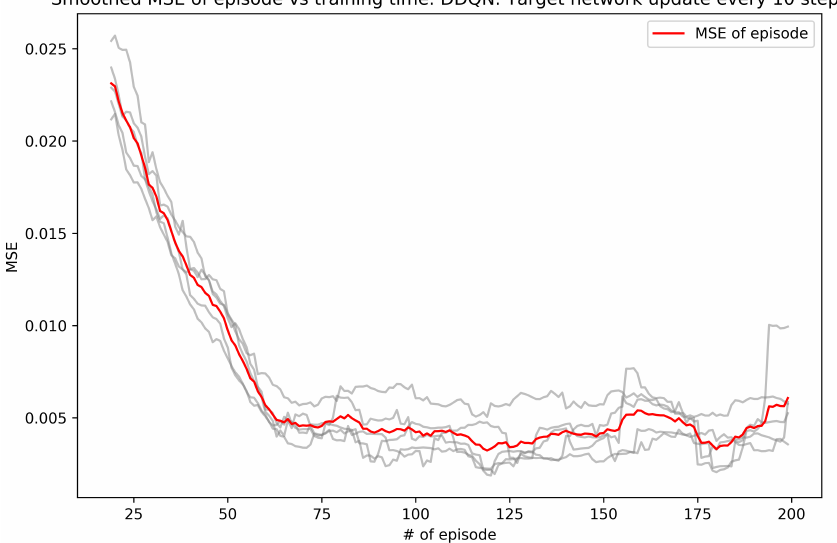
Figure 9. Smoothed MSE for the episode as a measure of the controller’s performance during training repeat (grey) and summarized (red).